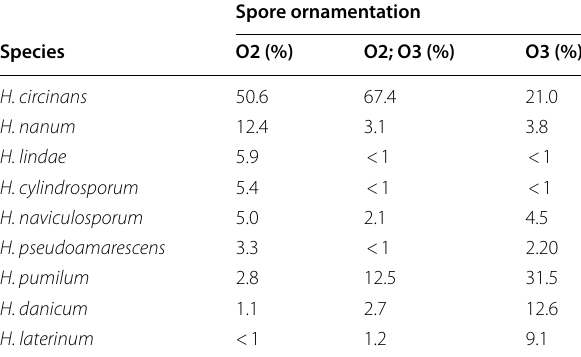
Table 10 The outputs of the identifier for the collection with parameters shown in Fig. 2 but now with the spore ornamentation (only) varied. As the ornamentation is identified as O3 instead of O2, the identification swings significantly from Hebeloma circinans to H.